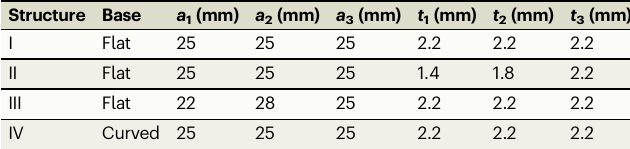
Table 1 | Geometry design parameters of MSO structures Structure